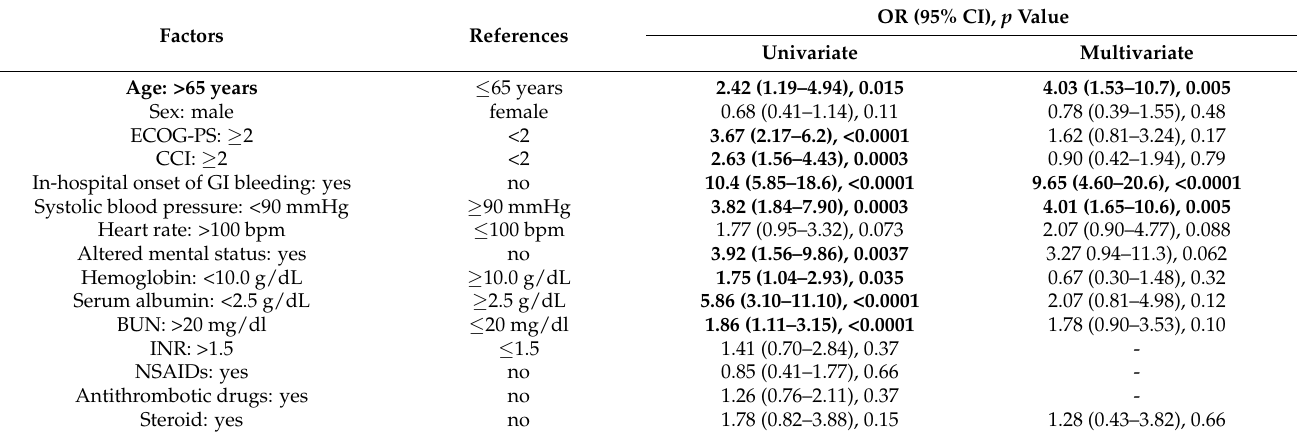
Table 2. Factors associated with AHRU among patients with lower gastrointestinal